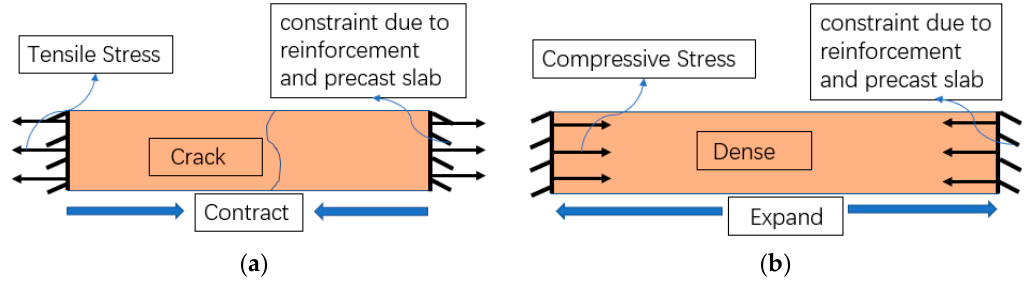
Figure 12. Stress produced by deformation under constraint: ( a ) REF; ( b ) MC and SMC.